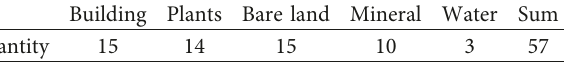
Table 2: Sample classification statistics of image B.